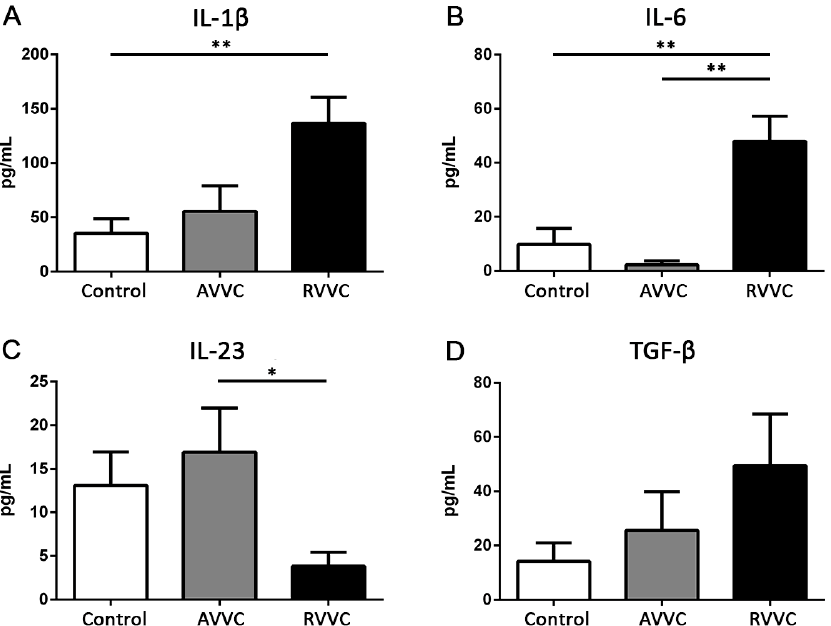
Figure 3. Cytokines concentration in cervicovaginal lavage samples from patients of the Control (white bars), AVVC (grey bars), and RVVC (black bars) groups, quantified by ELISA assay. ( A ) IL-1 β ( B ) IL-6, ( C ) IL-23, and ( D ) TGF- β . The assay could not be performed in all the patients of each cohort due to sample limitations. Mean ± SEM. Control n = 26, AVVC n = 18, RVVC n = 48. * p < 0.05, ** p < 0.01. ANOVA test.